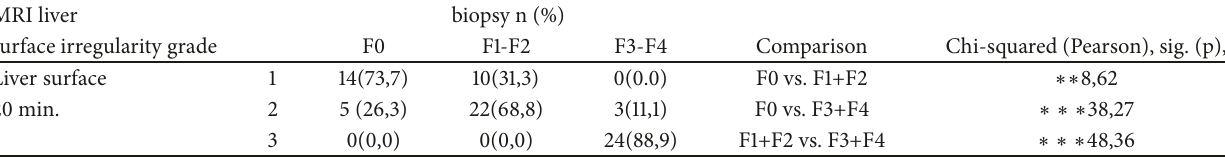
Table 5: The differences of liver surface parameter at 20 minutes post-Gd-EOB-DTPA injection among different categories of fibrosis.